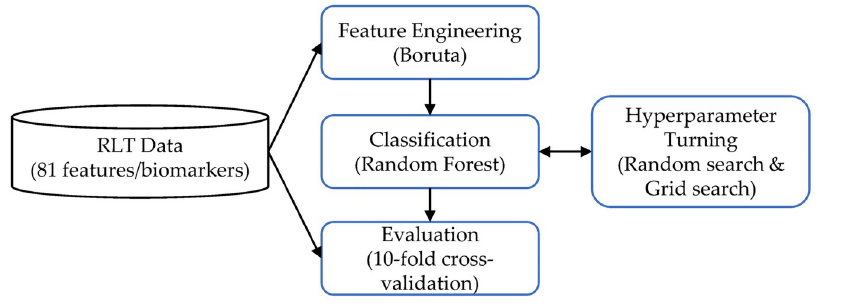
Fig 1. Schematic overview of the proposed